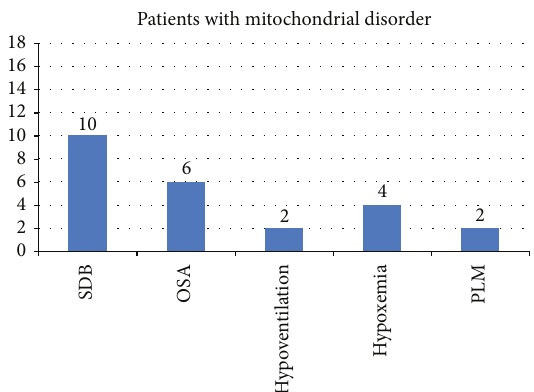
Figure 1: Sleep disordered breathing characteristics in 18 patients with mitochondrial